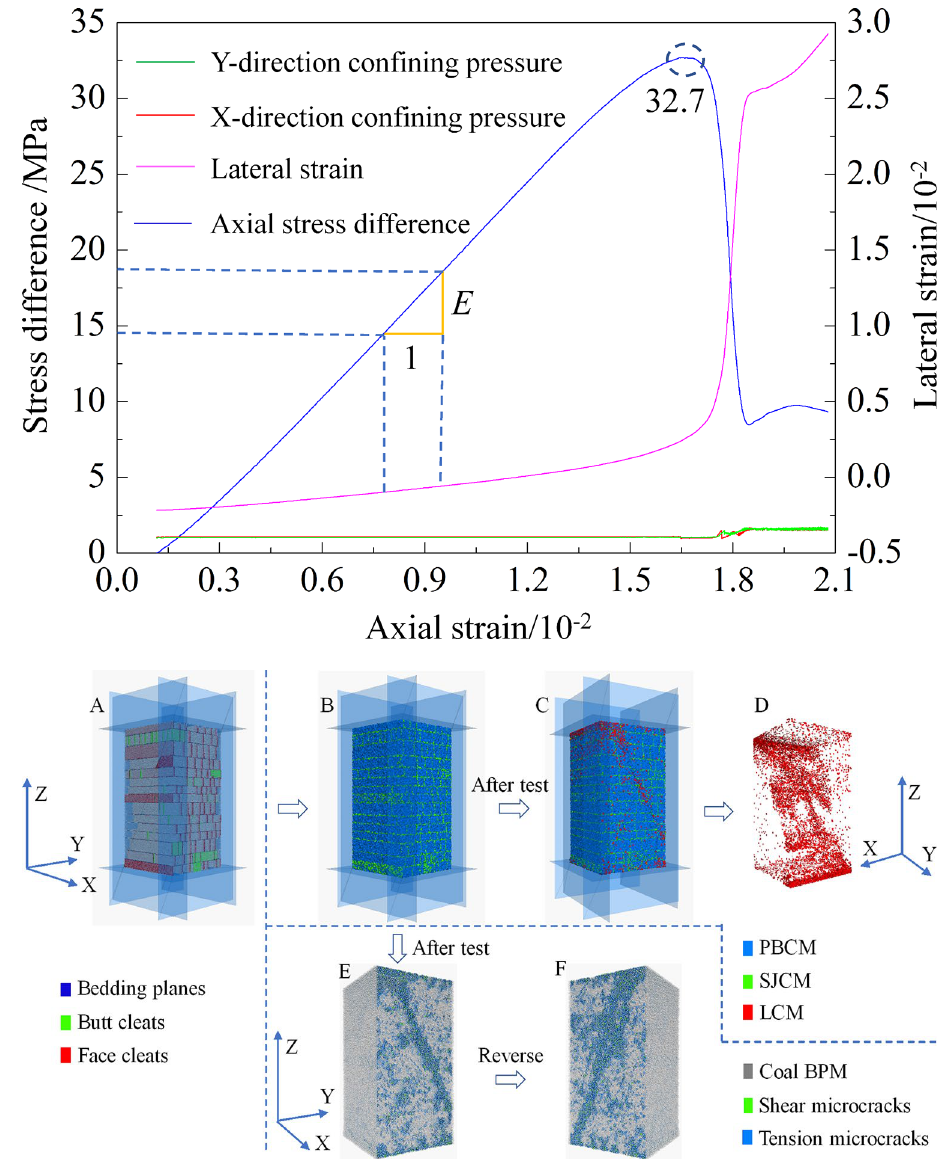
Fig. 6 Numerical results of stress and strain for intact coal with REV size after triaxial compres - sion